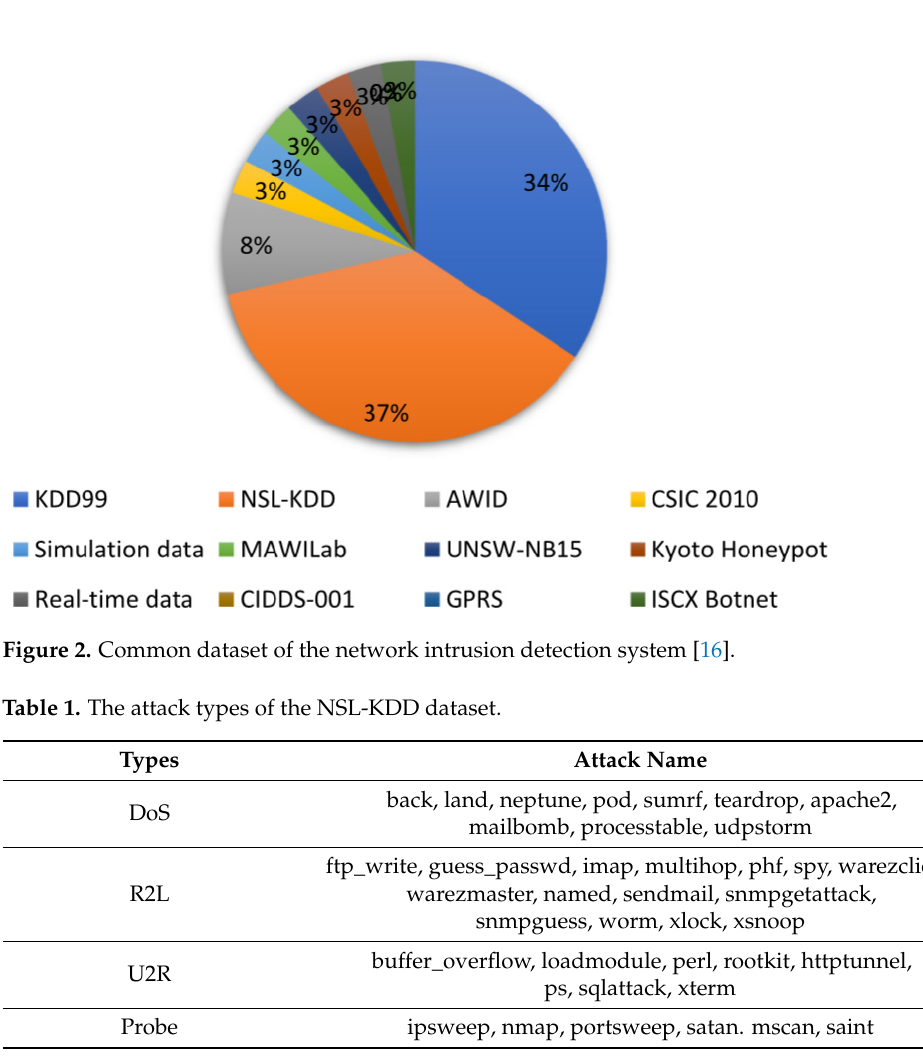
Table 1. The attack types of the NSL-KDD dataset.